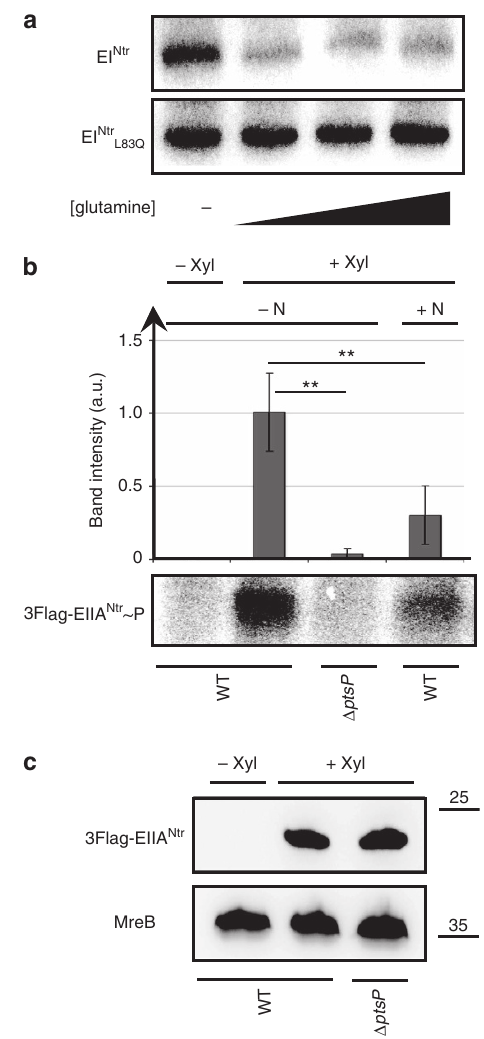
Figure 4 | Glutamine inhibits PTS Ntr phosphorylation. ( a ) Glutamine inhibits autophosphorylation of EI Ntr but not EI Ntr L83Q . Autophosphorylation assays of EI Ntr and EI Ntr L83Q using [ 32 P]PEP as a phosphoryl donor in the absence or presence of increasing concentration of glutamine (0, 2, 5, 10mM). The full autoradiography is available in Supplementary Fig. 8a. ( b ) The EI Ntr -dependent phosphorylation of EIIA Ntr is enhanced upon nitrogen starvation. In vivo phosphorylation assays of EIIA Ntr in (cid:2) N or þ N conditions supplemented with ( þ Xyl) or without ( (cid:2) Xyl) xylose in wild- type (WT) or D ptsP cells expressing 3FLAG-ptsN from P xylX promoter. Error bars ¼ s.d.; n ¼ 3. Statistically significant differences by Student’s t -test are indicated as ** P o 0.01% ( n ¼ 3). The full autoradiography is available in Supplementary Fig. 8b. ( c ) Immunoblotting of protein samples extracted from WT and D ptsP cells expressing 3FLAG-ptsN from P xylX promoter, incubated 3h in M5GG supplemented with ( þ Xyl) or without ( (cid:2) Xyl) xylose. MreB was detected in all conditions, while 3FLAG-EIIA Ntr was detected only in the presence of xylose. The full blot is available in Supplementary Fig.